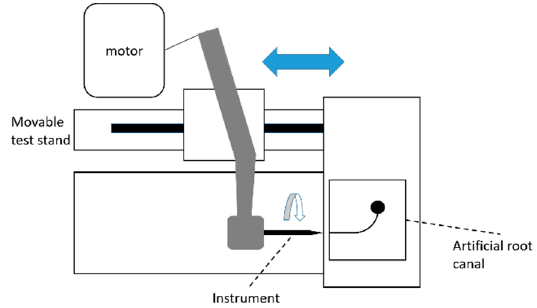
Figure 2. Schematic drawing showing the cyclic fatigue tester used in the experiment.